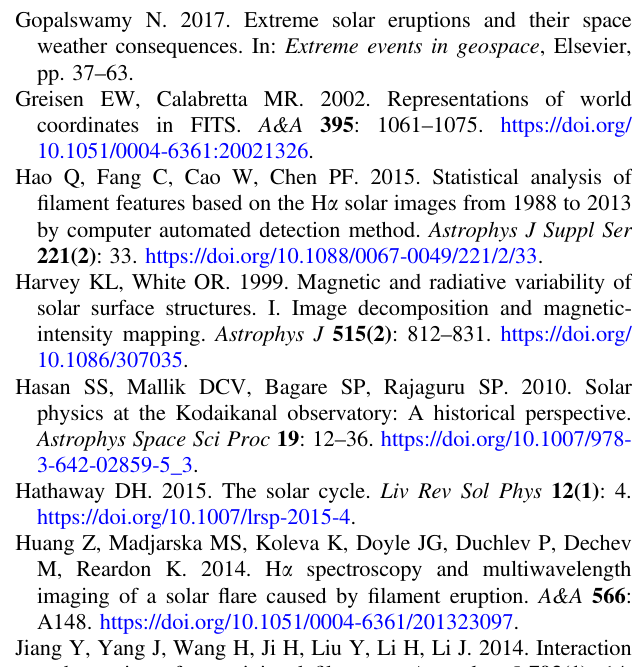
Supplementary Movie S1 : MPEG4 movie showing a typical wavelength exploration of Spectroheliograph datacubes